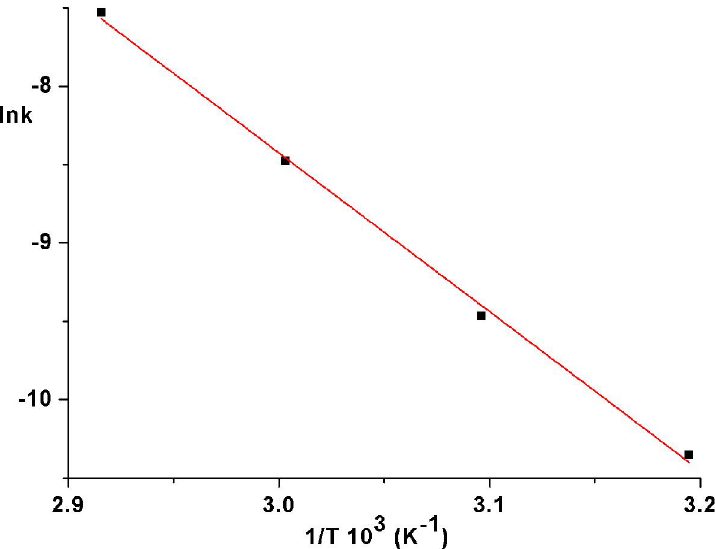
Figure 7. Arrhenius plot for thermal cis-trans isomerization rate constants for ABM 2.